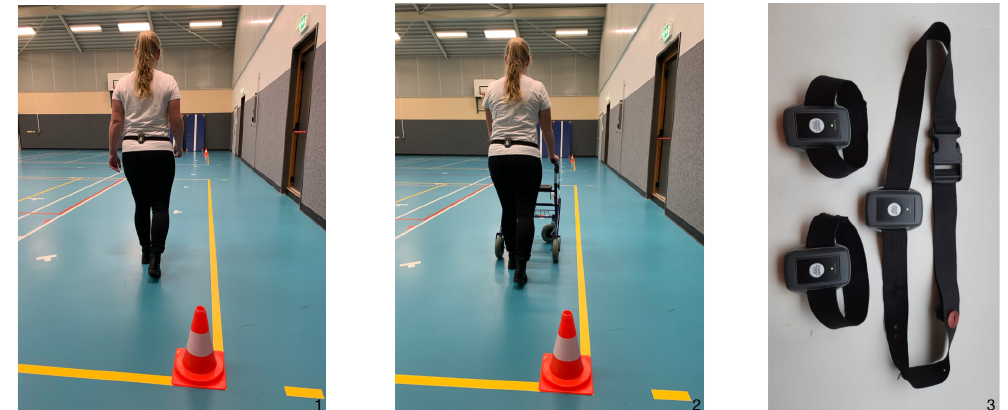
Figure A2. Participants walked on a 14-m path and took right turns around the cones ( 1 , 2 ). The use of a walking aid was optional. The three inertial measurement units were placed at the low back and on top of the left and right feet. Elastic bands were used to hold the sensors in place ( 3 ). A measurement was started and stopped by pressing the white start/stop button on the IMUs. After a measurement, the data was stored on the IMU and accessed by connecting the IMU to a computer. The person in the images did not participate in the